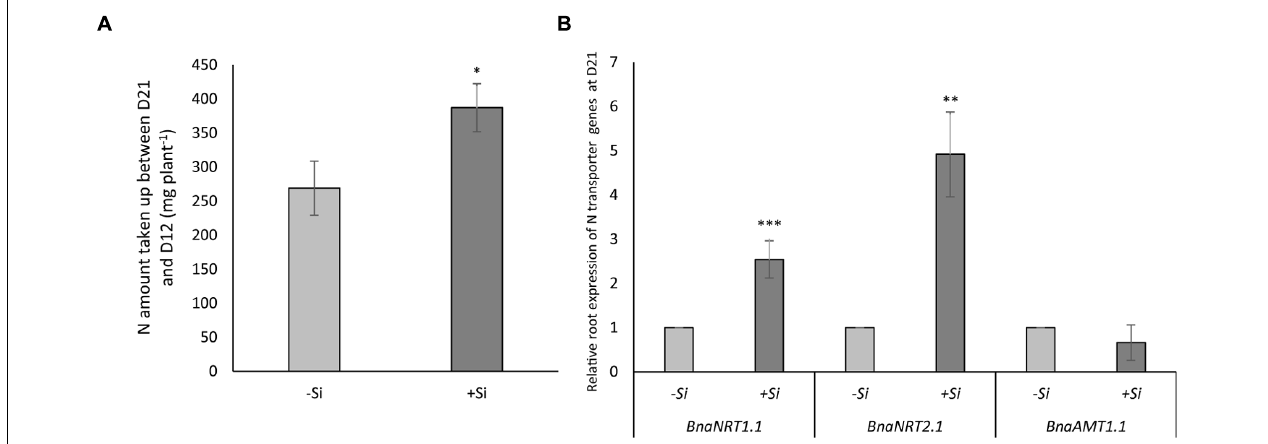
FIGURE 7 | Amount of nitrogen taken up by plants between 12 (D12) and 21 days (D21; A ), and the relative root expression of the BnaNRT1.1 , BnaNRT2.1 , and BnaAMT1.1 genes in Brassica napus (B) . Plants were pretreated with (+Si) or without (Control: –Si) silicon after N starvation for 12 days (D12) and 9 days after N resupply (D21). Data are means ± SE ( n = 3). ∗ , ∗∗ and ∗∗∗ indicate significant differences between –Si (Control) and +Si plants with p < 0.05, p < 0.01 and p < 0.001,